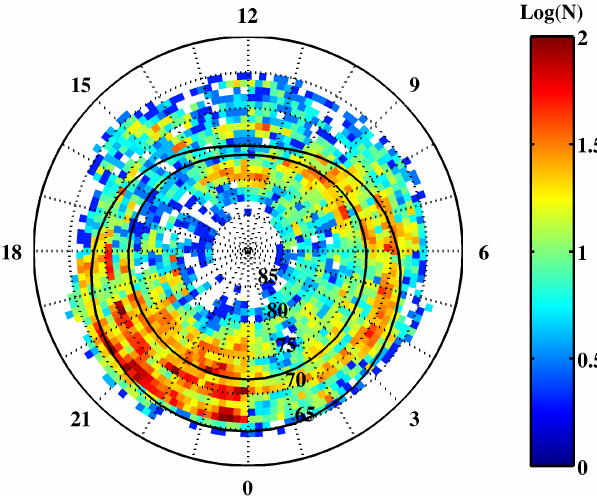
Fig. 1. Spatial distribution of the occurrence of radar echoes in our database, in MLT/ 3 (Invariant Magnetic Latitude) AACGM co- ordinates. The occurrence is colour-coded on a logarithmic scale. The boundaries of the auroral oval, defined by Holzworth and Meng (1975) for a moderate geomagnetic activity (3 <K p < 4 − ) are over-